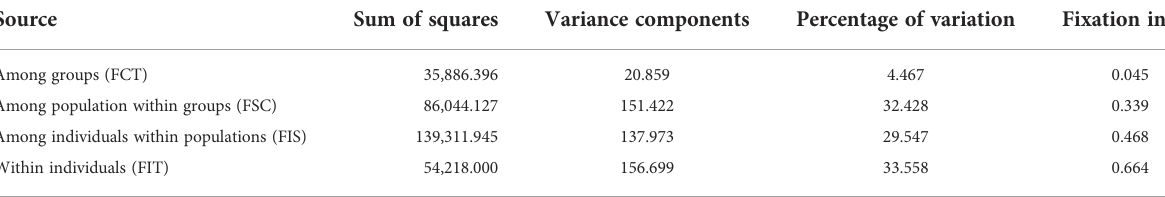
TABLE 4 Results of AMOVA partitioning the genetic variation of Sicyos angulatus in Korea representing 16 populations within four river basins and eight populations from east coastal streams (see Table 1 for the regions). Source Sum of squares Variance components Percentage of variation Fixation index